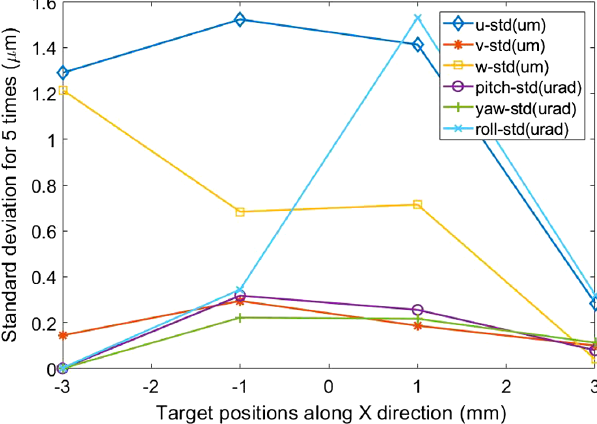
FIG. 13. Standard deviations of transitions along the X direc- tion for five